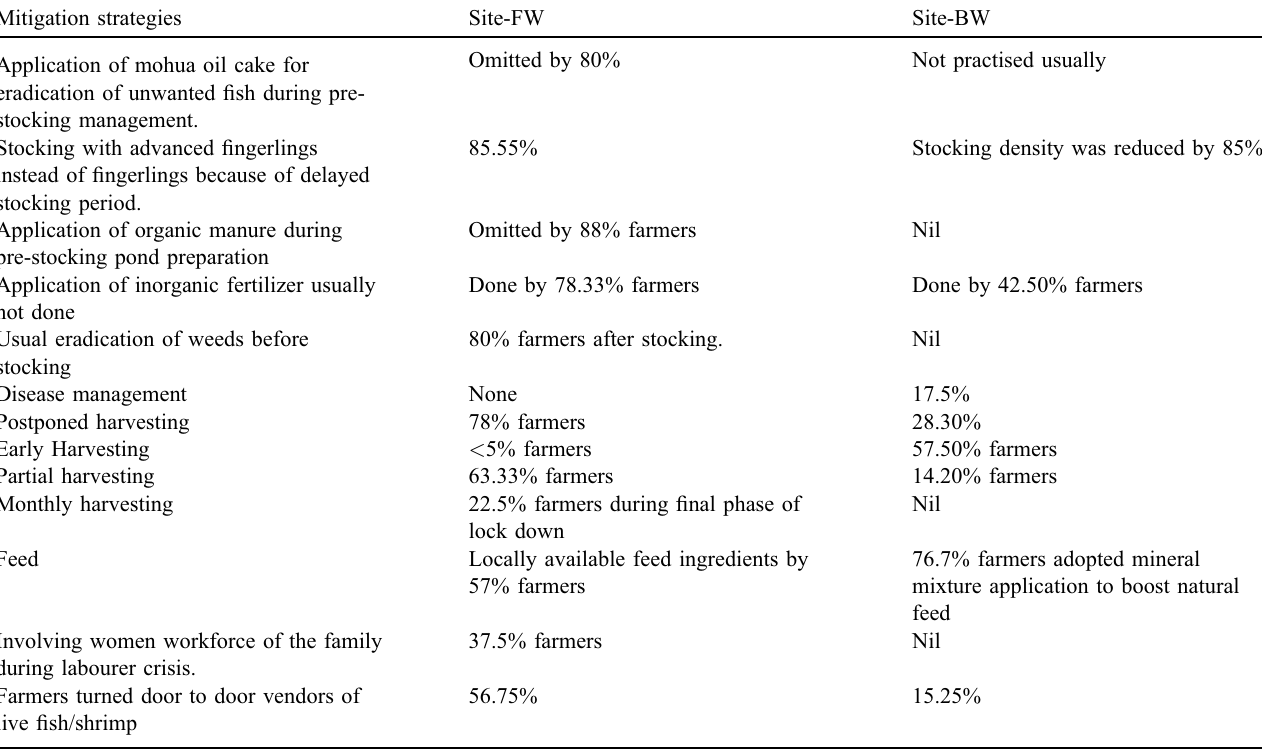
Table 1. Mitigation strategies adopted by the farmers during COVID-19.